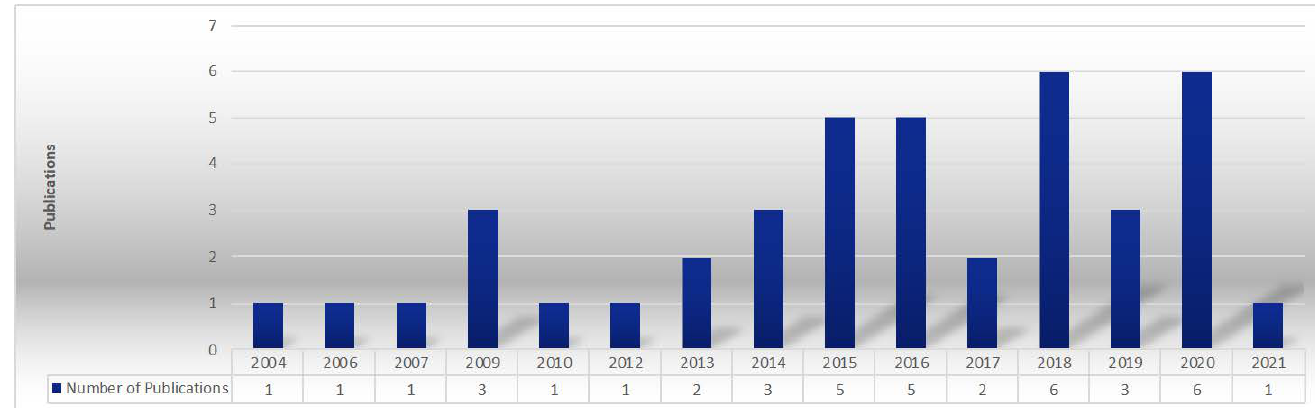
Figure 3. Frequency of the number of publications per year in mobile recycling domain.